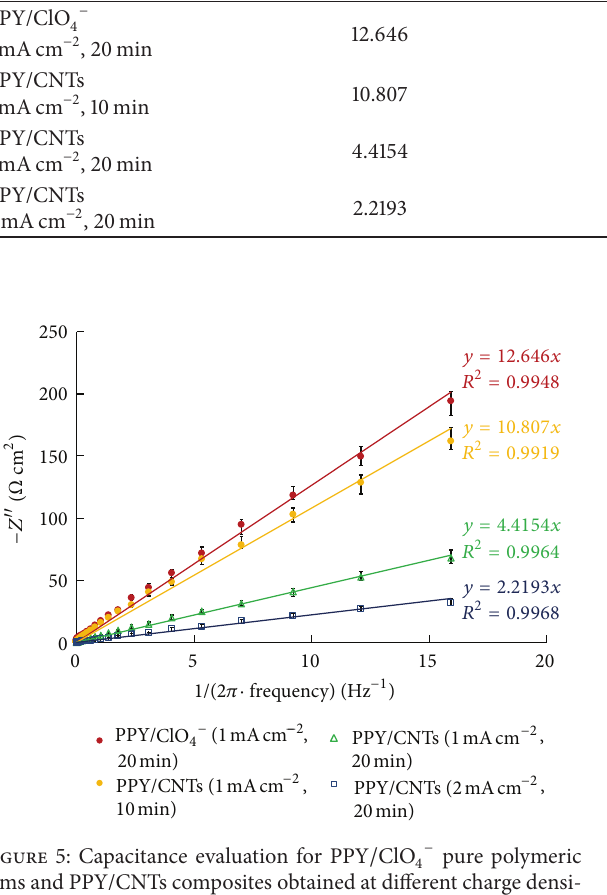
Table 1: Capacitance and real impedance values at 0.01 Hz for pure polymeric and composite films. Modified electrode